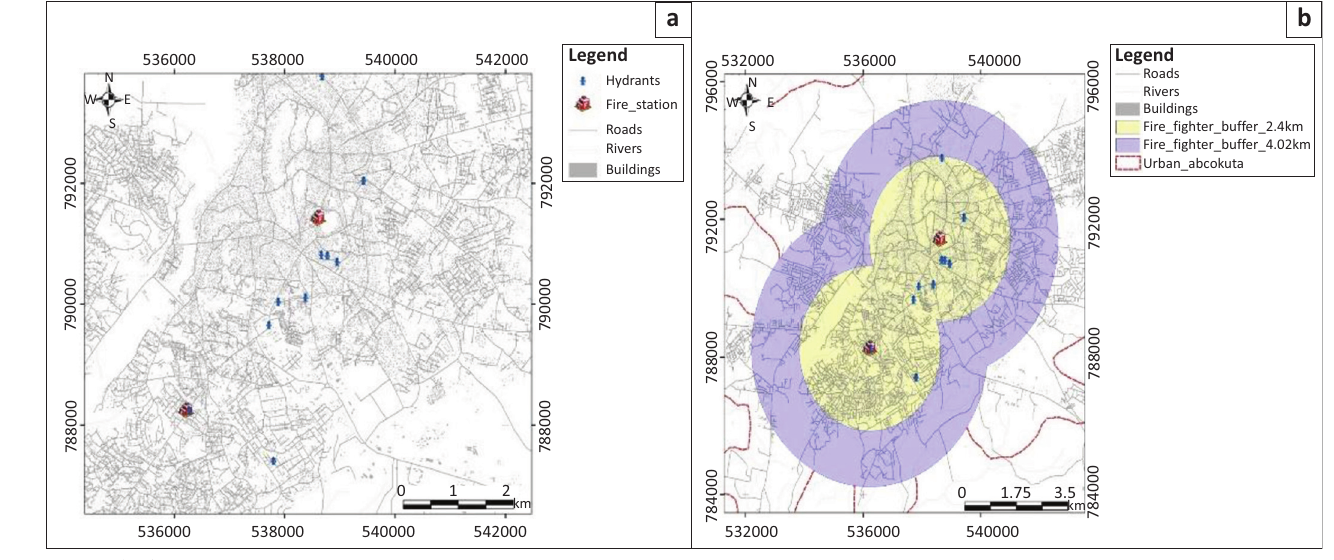
FIGURE 11: (a) Spatial distribution of hydrants and (b) US Insurance Services Office -based buffer of fire